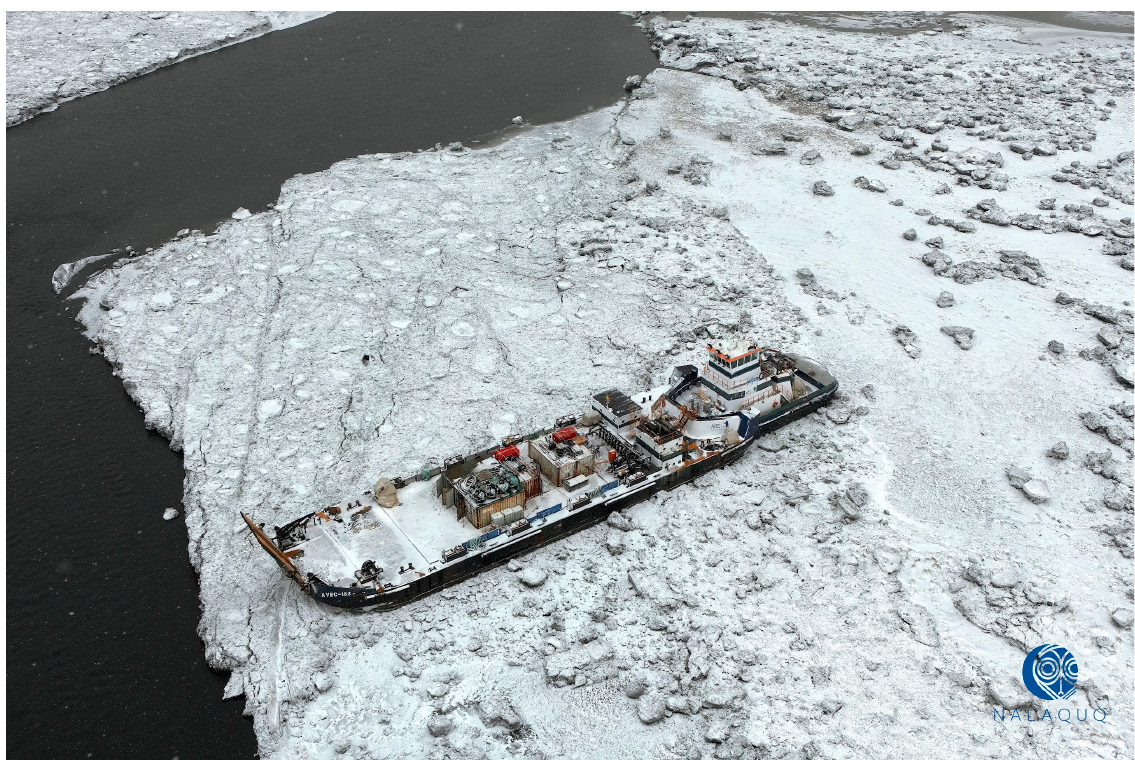
Figure 8. A UAV still image of a grounded barge at the mouth of the Qanirtuuq river in fall of 2022. Image courtesy of Bryan Jones, Quinhagak AK.